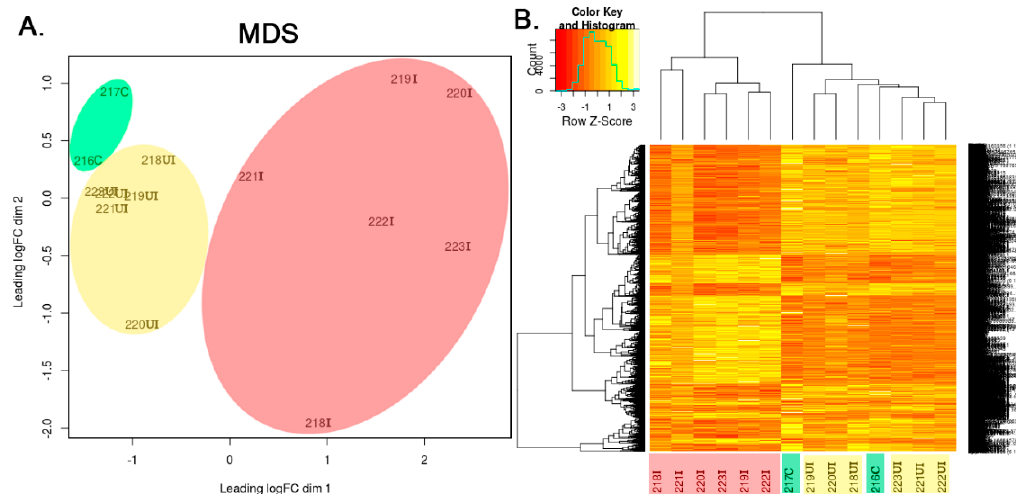
Figure 1. In silico performed multidimensional scaling (MDS) of individual transcriptomic data clustered samples into control, 2,4,6-trinitrobenzene sulfonic acid (TNBS)-treated uninflamed and TNBS-treated inflamed groups, while examination of significantly altered transcripts confirmed these observations. ( A ) MDS of individual rat colon samples and ( B ) Representative heatmap image of significantly altered transcripts in the control (green, n = 2), TNBS-treated uninflamed (yellow, n = 6), TNBS-treated inflamed (red, n = 6) tissues. The heatmap contains 3766 genes that displayed significant gene expression change in at least one of the three comparisons made. In the sample IDs, the abbreviations “C,” “UI” and “I” represent control, uninflamed and inflamed sample groups, respectively.